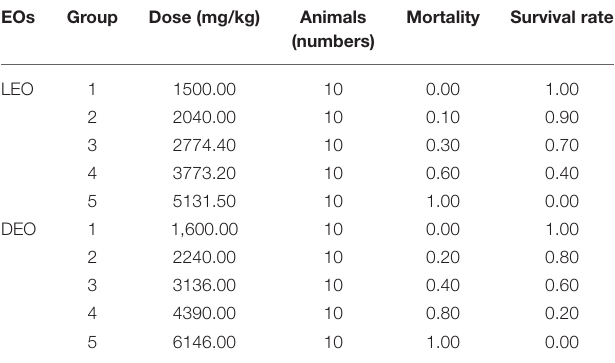
TABLE 3 | Acute oral toxicity of essential oils in mice.